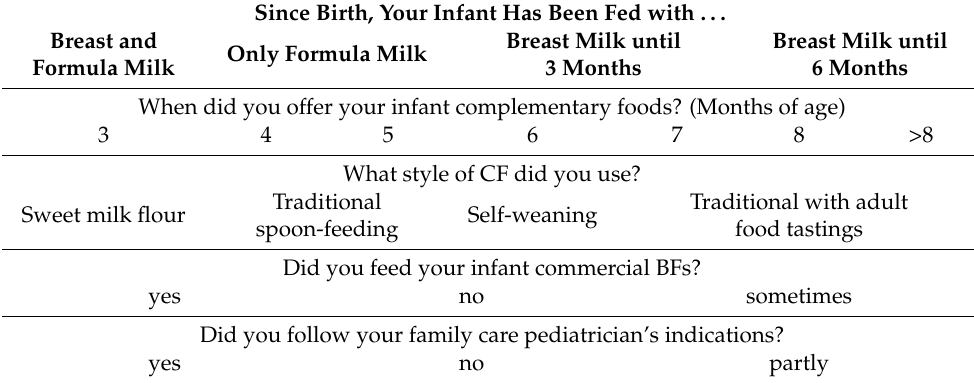
Table 2. Multiple-choice questionnaire sent to